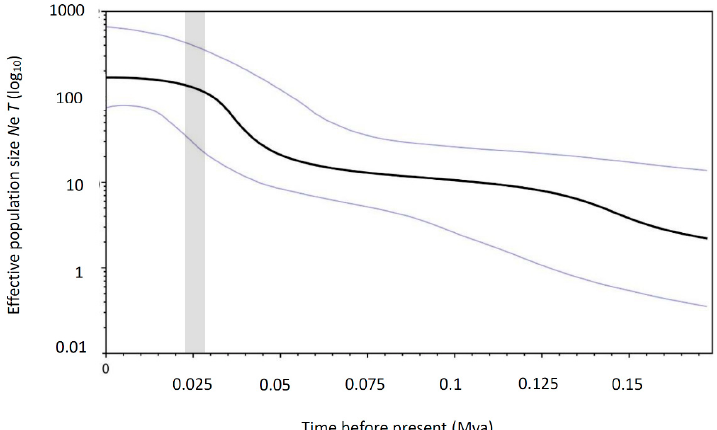
Figure 4. Bayesian skyline plot of the effective population sizes over time for Macrobrachium japonicum based on partial mtDNA COI gene. The units of the X axis are millions of years, and the units of the Y axis are Ne (the log-transformed product of effective population size and generation length in years). Median estimated effective population sizes (bold lines) are enclosed within 95% highest posterior density intervals (light gray lines). The estimated time-frame of the Last Glacial Maximum is denoted by the area shaded in dark grey.